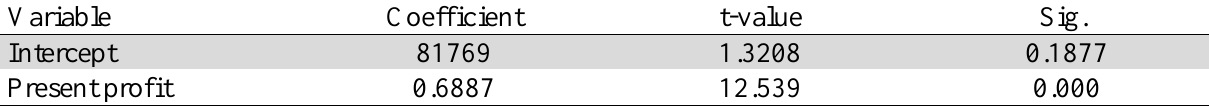
The summary of the regression model on testing the first hypothesis Variable